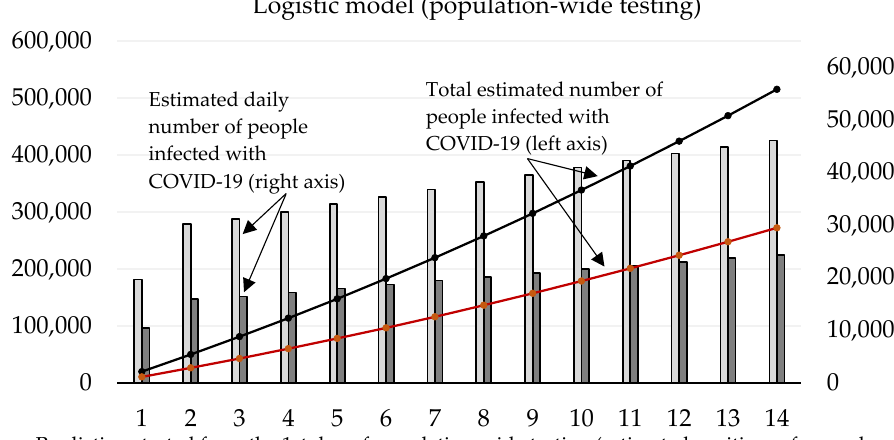
Figure 6. Forecast of the cumulative number of infected people (caused by those who would not be discovered by nationwide testing) based on the exponential model.